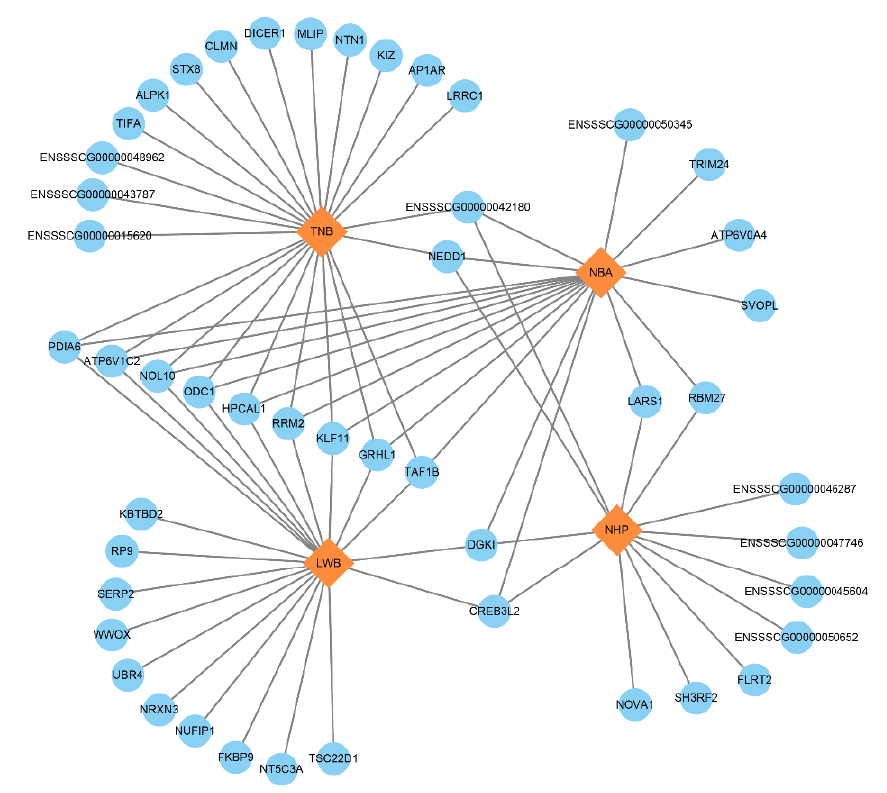
Figure 3. The 49 protein coding genes related to four reproductive traits. The blue circles represent genes and the orange diamonds represent traits. TNB: total number born; NBA: number born alive; NHP: number healthy piglets; LWB: litter weight born alive.